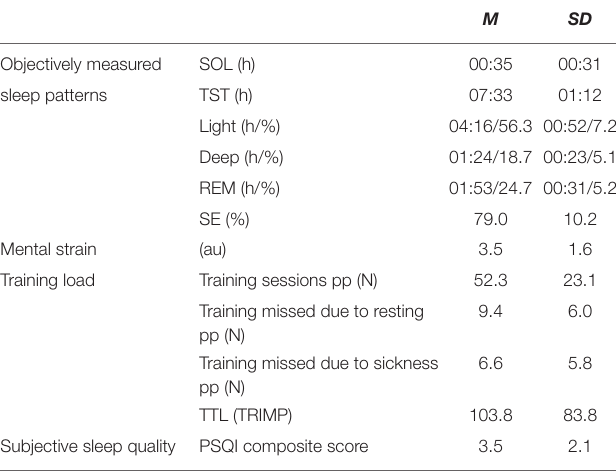
TABLE 3 | Descriptive statistics for objectively measured sleep patterns, mental strain, training load, and subjective sleep quality, reporting means and SD, in 56 junior endurance athletes.